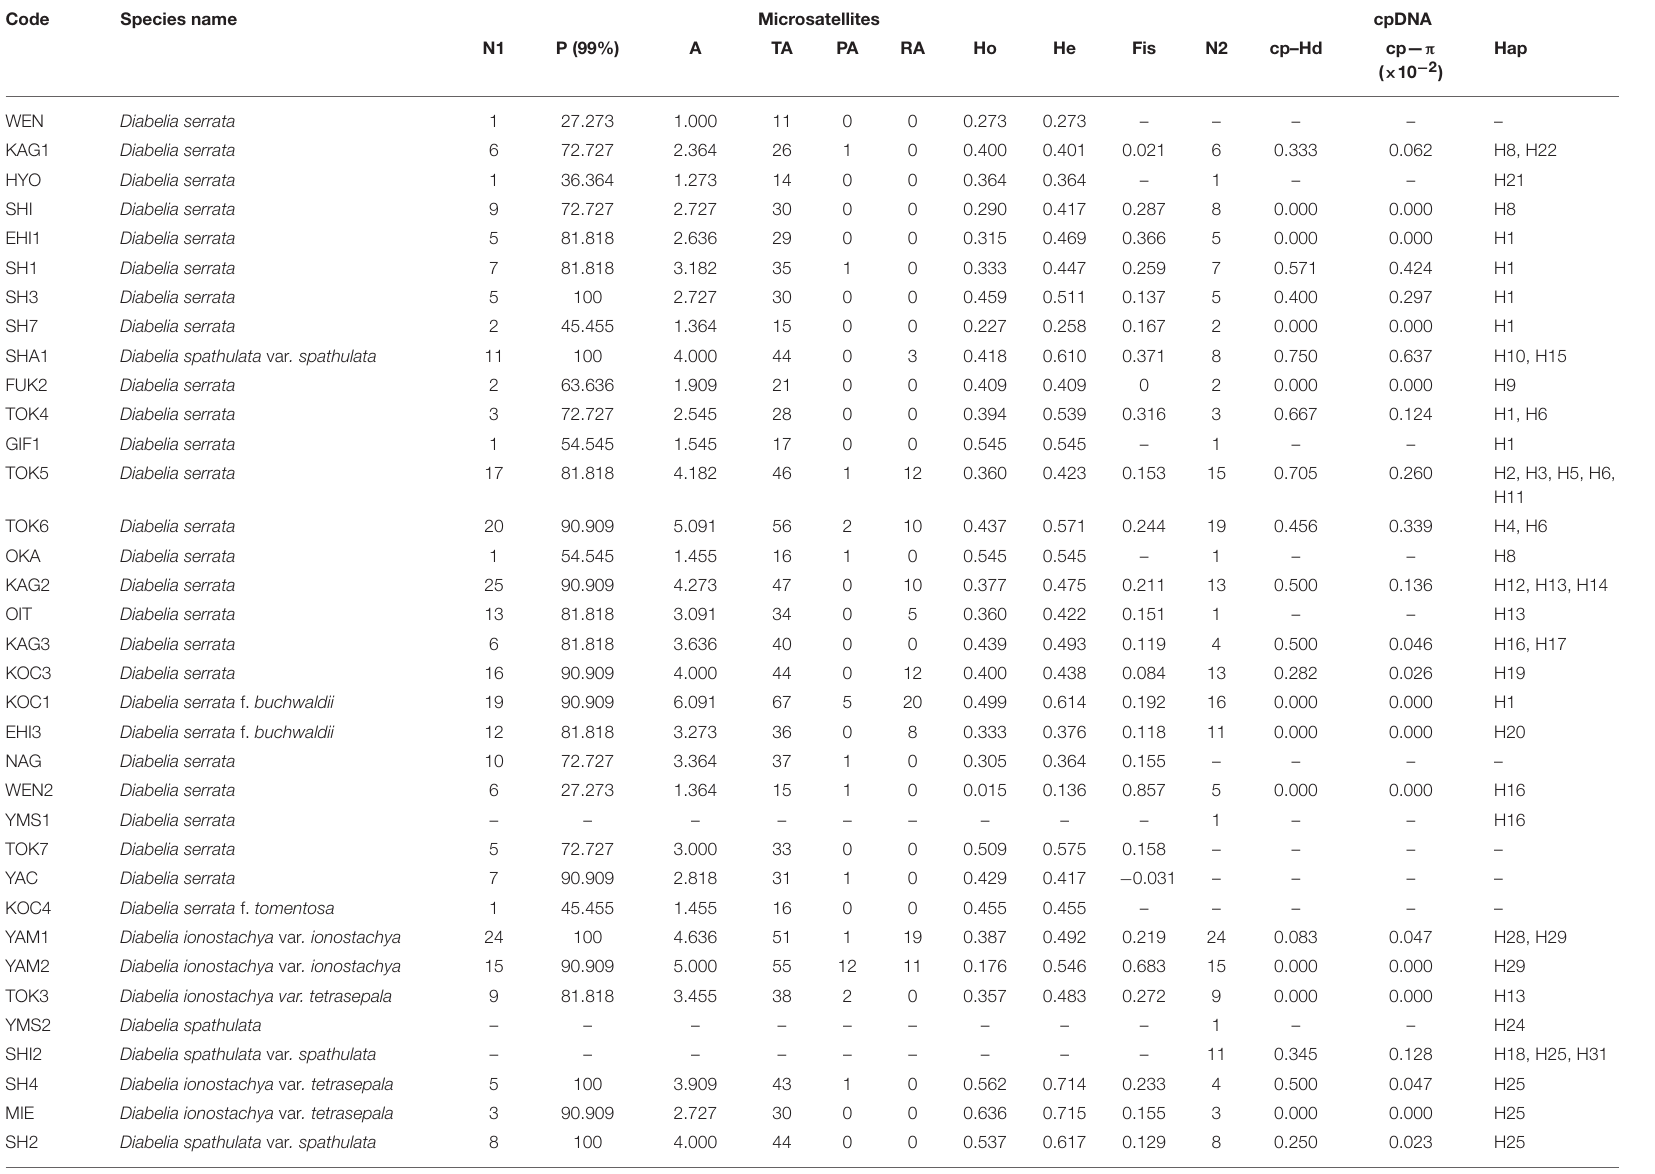
TABLE 2 | Genetic characteristics of 59 Diabelia populations from China, Japan, and Korean surveyed for chloroplast (cp) DNA sequences and nSSR